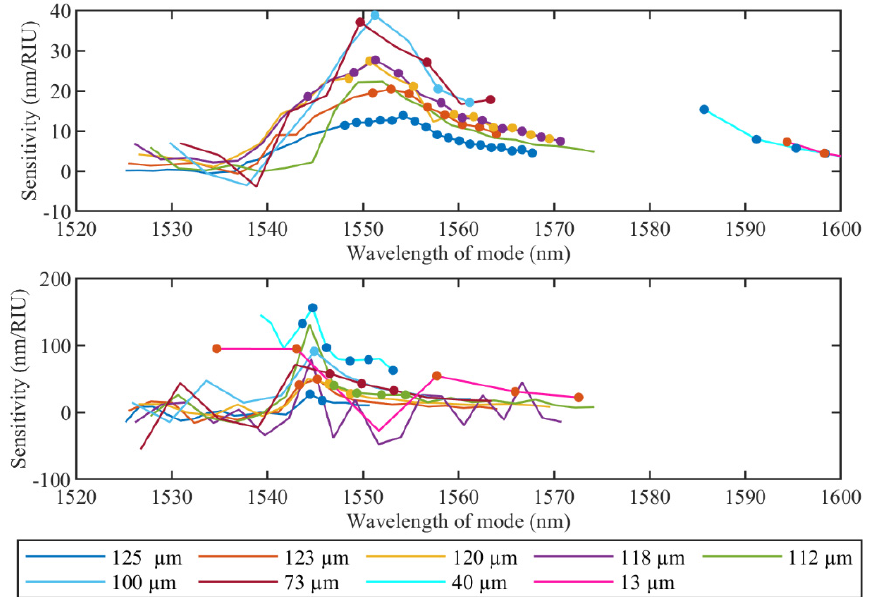
Figure 8. Evolution of the wavelength sensitivity for the high RI range from 1.33679 RIU to 1.37078 RIU ( upper ) and the small RI range from 1.34722 RIU to 1.34873 RIU ( lower ) of cladding modes during etching process. Dot markers show the modes with sensitivity linearity higher than 0.9 (R 2 > 0.9).